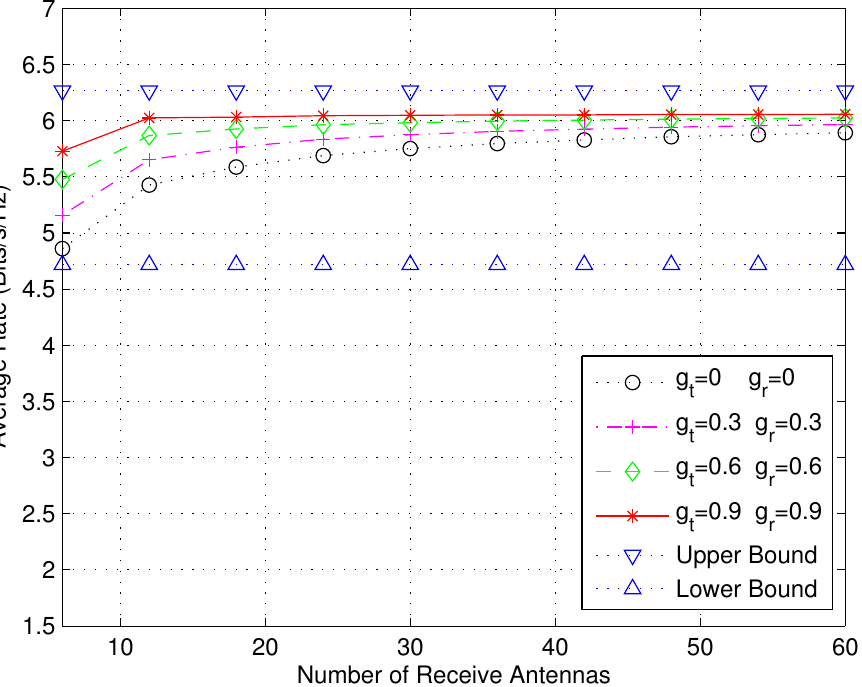
Figure 1. The ergodic achievable rate versus the number of receive antennas for comparing the case with correlation and the case without correlation.